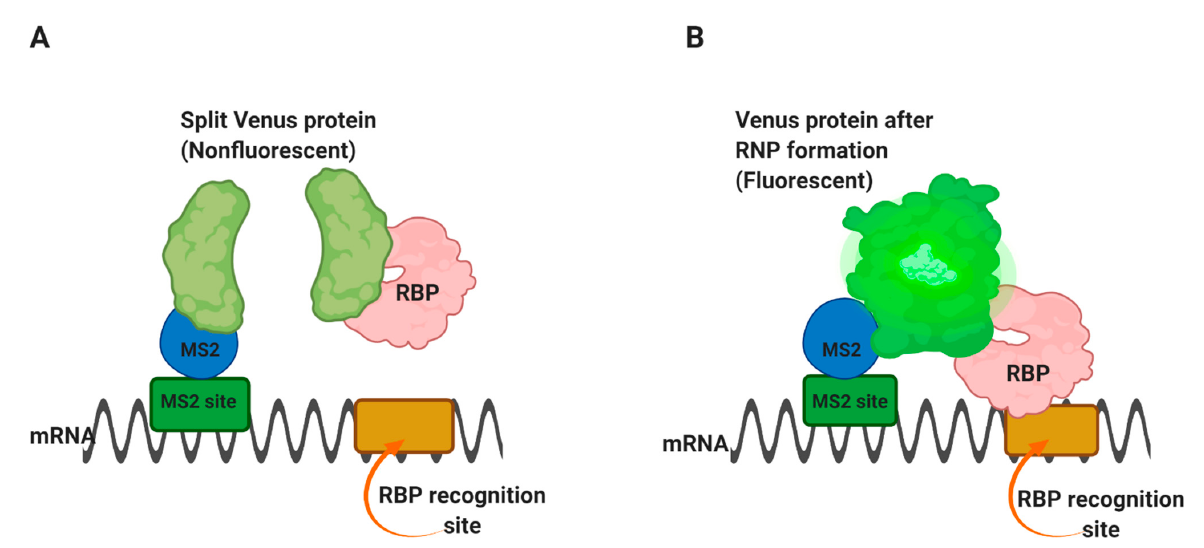
Figure 4. TriFC method in living cells. The TriFC helps detect RNA-protein interaction in living cells. ( A ) Two complementary portions of the Venus fluorescent protein are attached to a reporter mRNA by the MS2 coat protein and an RNA-binding protein, respectively. ( B ) If the RNA-binding protein finds a preferred sequence within the reporter mRNA and binds there, the two portions of Venus protein will be brought into proximity to form a fluorescent product [55].